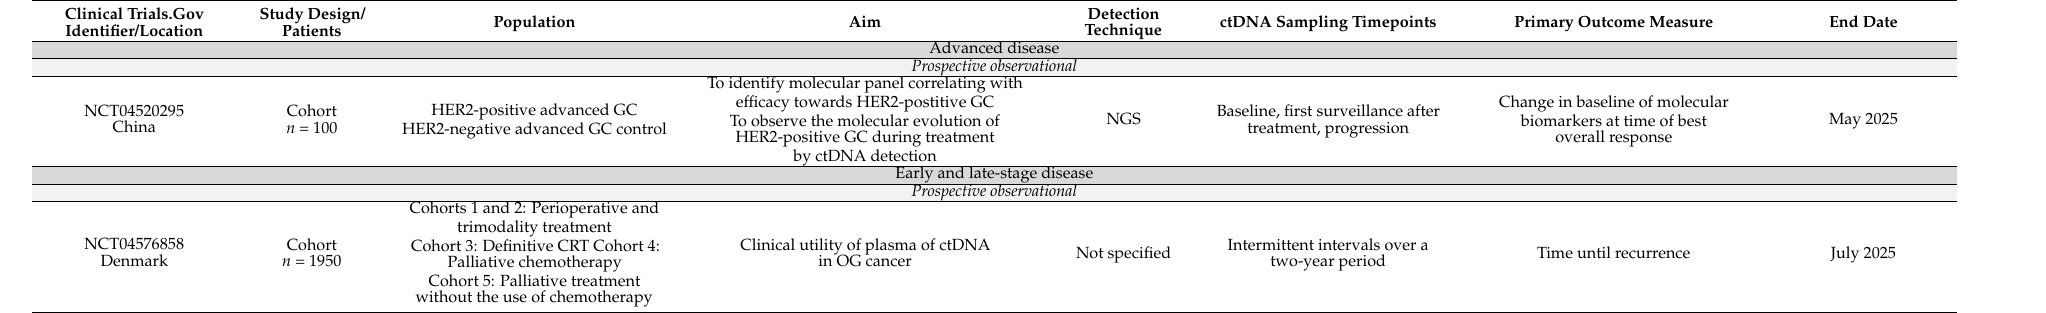
Clinical Trials.Gov